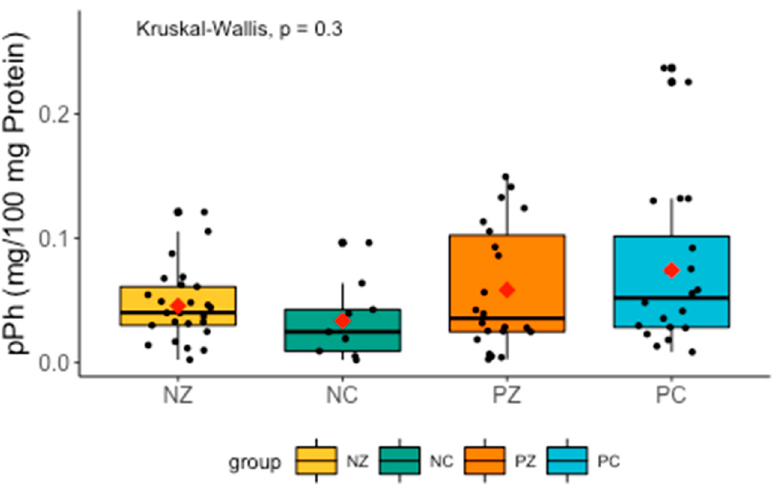
Figure 6. Levels of pPh in the examined groups. pPh, total phenolic content; NZ, generally healthy patients without the BRCA1 mutation; NC, patients with breast cancer but without the BRCA1 mutation; PZ, generally healthy patients with the BRCA1 mutation; PC, patients with both breast cancer and the BRCA1 mutation.